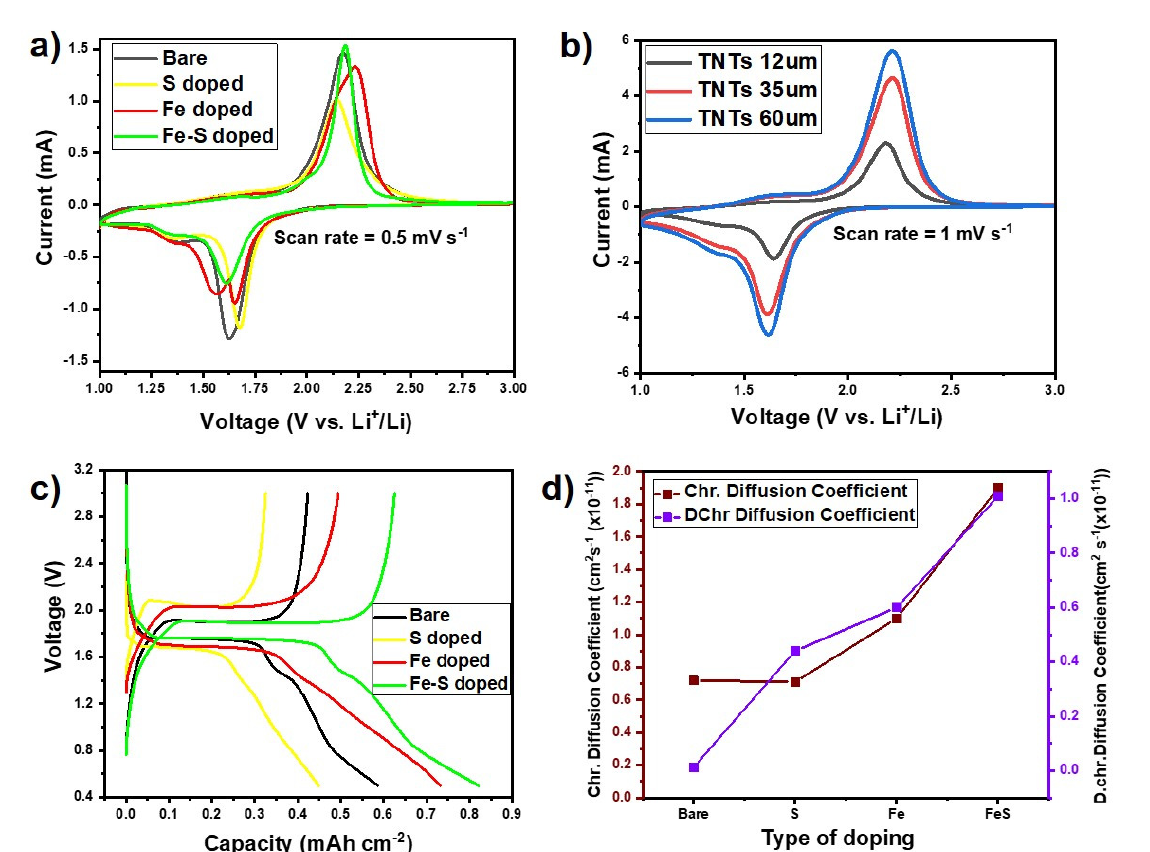
Figure 4. ( a ) Cyclic voltammograms of bare, Fe, S, and Fe-S doped TNTs with respect to Li metal at a scan rate of 0.5 mV s − 1 . ( b ) Cyclic voltammograms of TNTs with the different thickness of 12 µ m, 36 µ m, and 60 µ m. ( c ) 1st charge-discharge profiles of bare, Fe, S, and Fe-S doped 12 µ m thick TNTs at 0.5 C. ( d ) Diffusion coefficient values calculated from Randles–Sevcik equation for bare, Fe, S, and Fe-S doped TNTs.